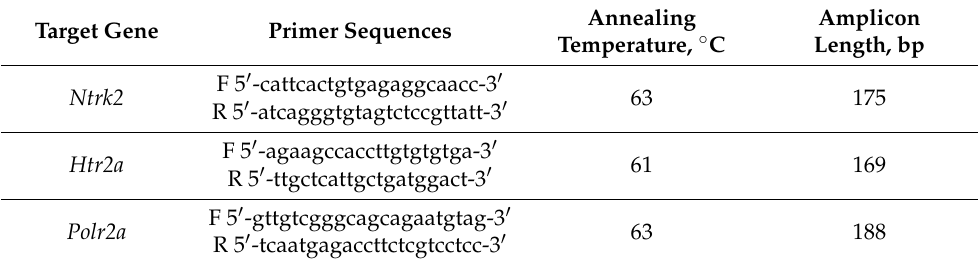
Table 1. The primer sequences, annealing temperatures, and PCR products’